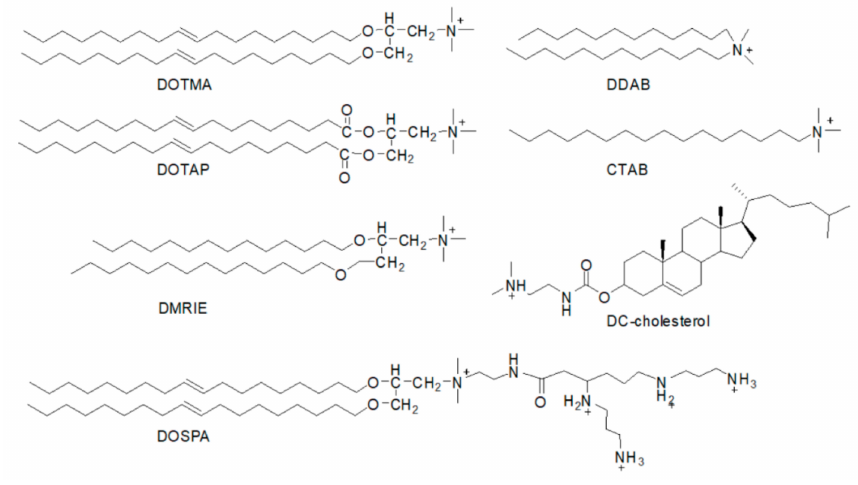
Figure 2. The structures of cationic